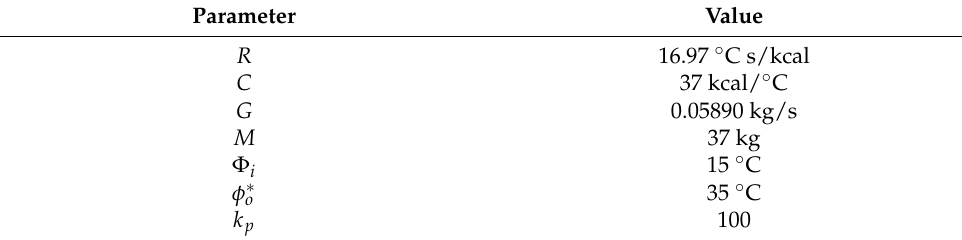
Table 2. Input parameters for hot water recirculation system simulation.